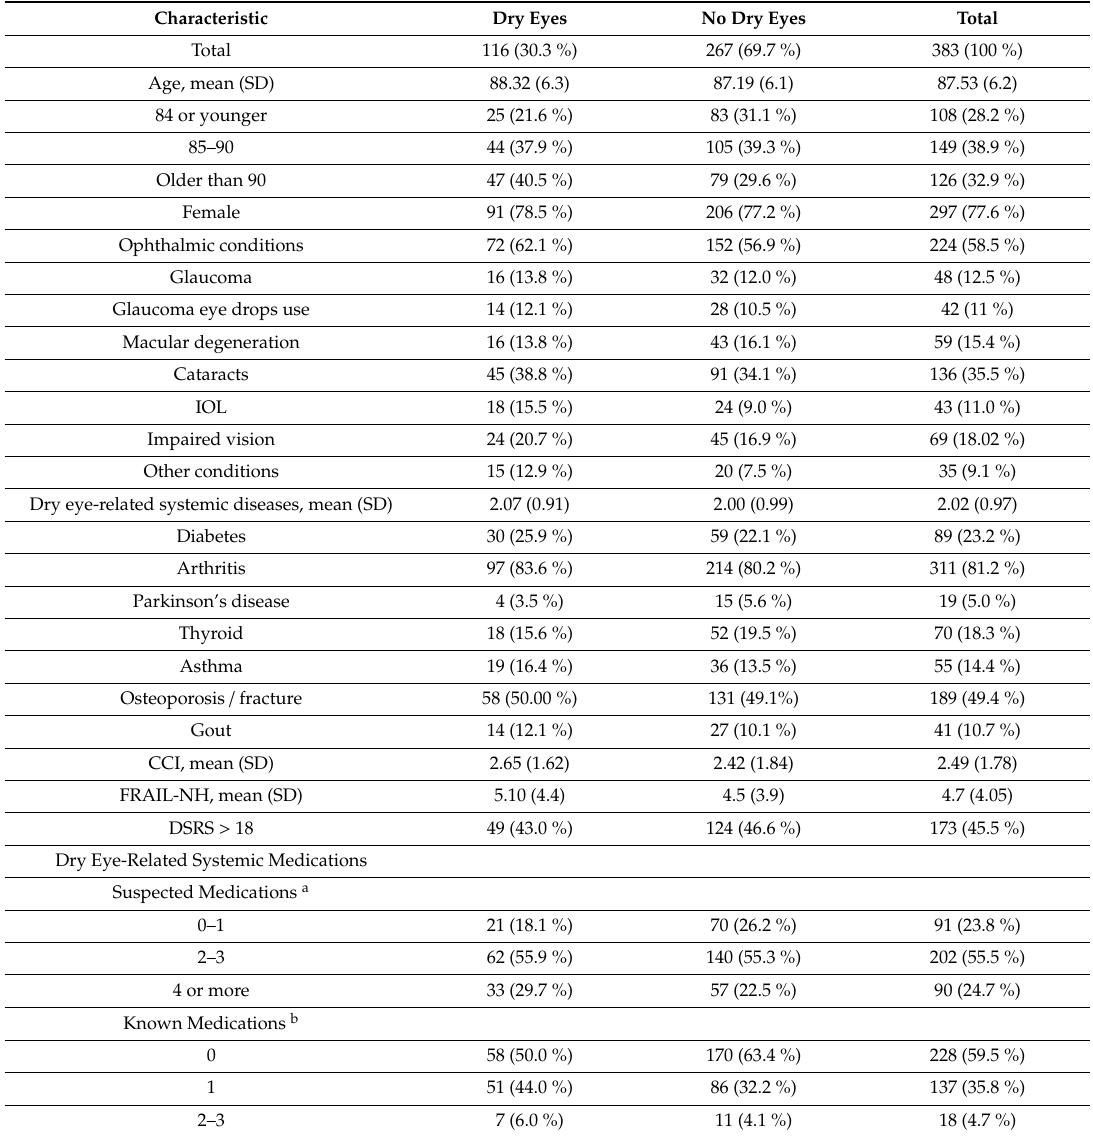
Table 1. Baseline characteristics of participants with and without dry